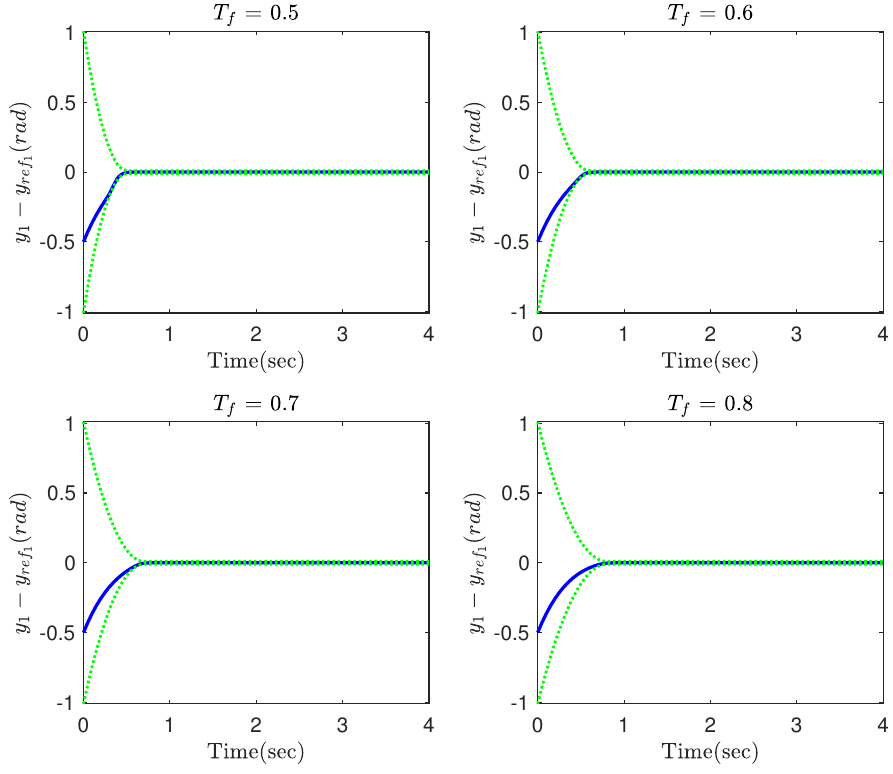
Figure 2. The tracking error of the first joint under different T f